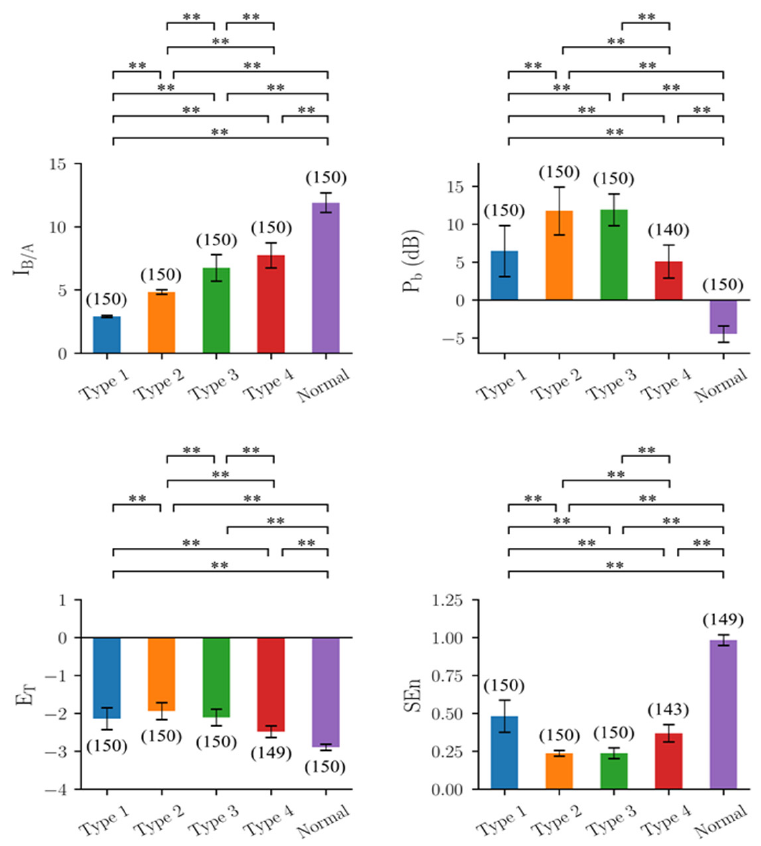
Figure 3. Results of the four indicators on the model output z(t) produced by the mathematical seizure model. I B/A : estimated B/A from CSCKF, P b : band power in the frequency range of 4–50 Hz, E T : Teager energy operator, and SEn: sample entropy. The colored bar shows the mean value for each group, and the error bar shows the corresponding range of ± 1 standard deviation. The number within the parentheses is the number of EEG segments, where the outliers have been excluded through the 1.5 inter-quartile range rule. **: Significant difference ( p -value < 0.01) tested by multiple comparisons using non-parametric Mann–Whitney U tests with Bonferroni corrections with α = 0.01.